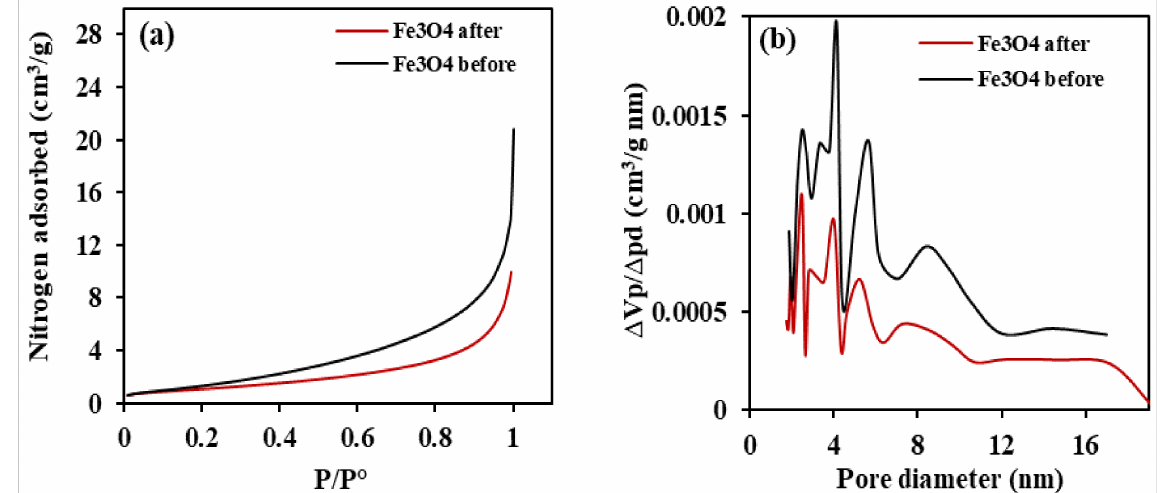
Figure 5. Graphical representation of ( a ) nitrogen adsorption isotherms at 77 K and nonlocal density functional theory (NLDFT) method of ( b ) micropore size distribution of